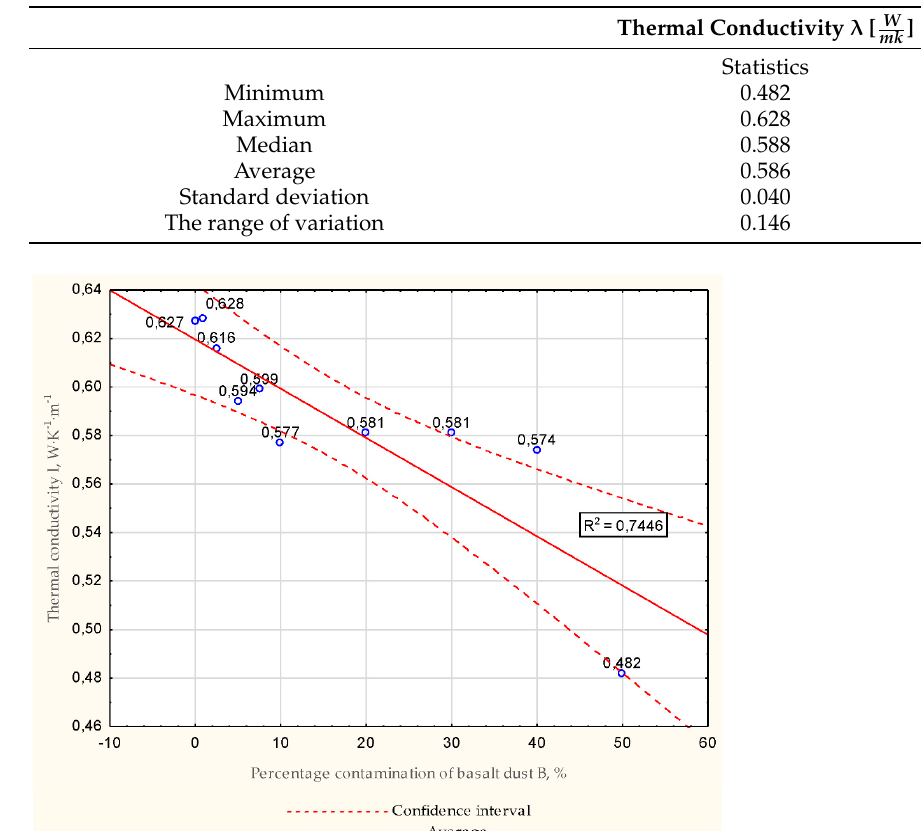
Figure 12. Average thermal conductivity for basalt dust B for water − mix ratio = 0.5.